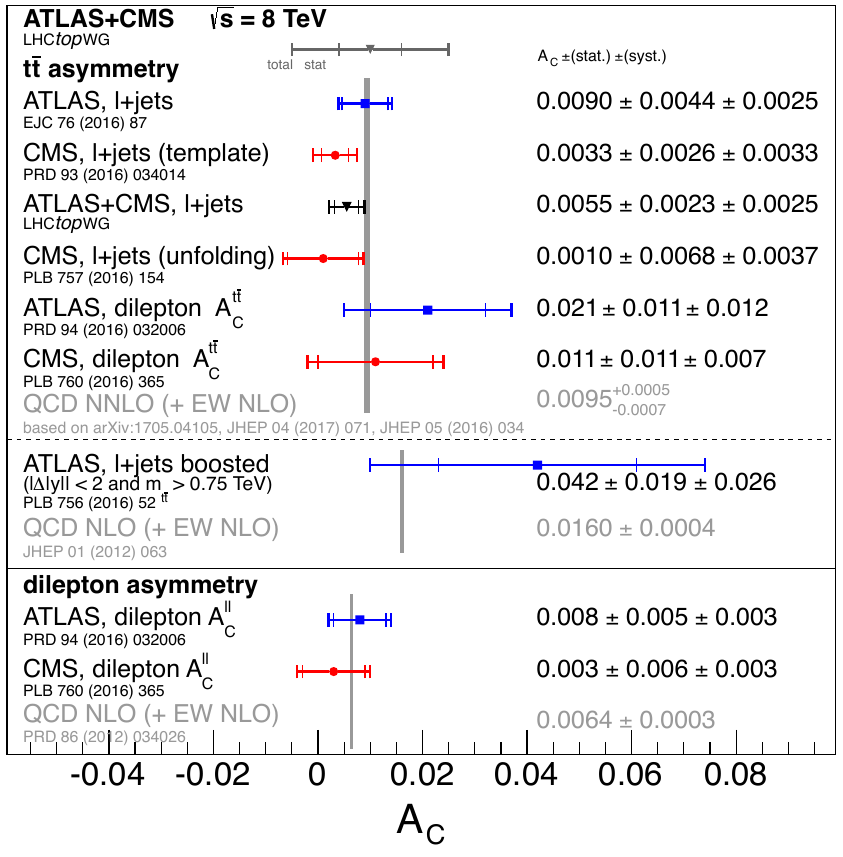
Figure 21. Summary of inclusive results at 8 TeV centre-of-mass energy [37]. The individual t ¯ t charge asymmetry values as a function of the invariant mass of the t ¯ t system along with the combined values can be found in Figure 22 (left). Depending on the bin, the ATLAS result contributes with weights between 0.22 and 0.59 to the combined value, while the weights of the CMS results vary between 0.41 and 0.78. The overall tendency is that the ATLAS result dominates the low mass region, while the CMS result dominates the high mass region. The total χ 2 of the combination with six degrees of freedom is 4.01 and corresponds to a p -value of 0.69. The improvement in precision ranges, again depending on the bin, between 20 and 52% for the ATLAS analysis and between 9 and 31% for the CMS analysis. In Figure 22, (right), the resulting combined charge asymmetry as function of m t ¯ t is compared to two theory predictions for the SM, calculated at NLO [14] and NNLO [57–59], respectively, and to two versions of a colour-octet model [43]. The latter is chosen as its prediction for A FB is in agreement with the Tevatron results and its deviations with respect to the SM prediction for A t ¯ t are—for the heavy version—on the C order of the measurement uncertainty. Within this uncertainty the combined values are comparable with the SM prediction as well as with both BSM